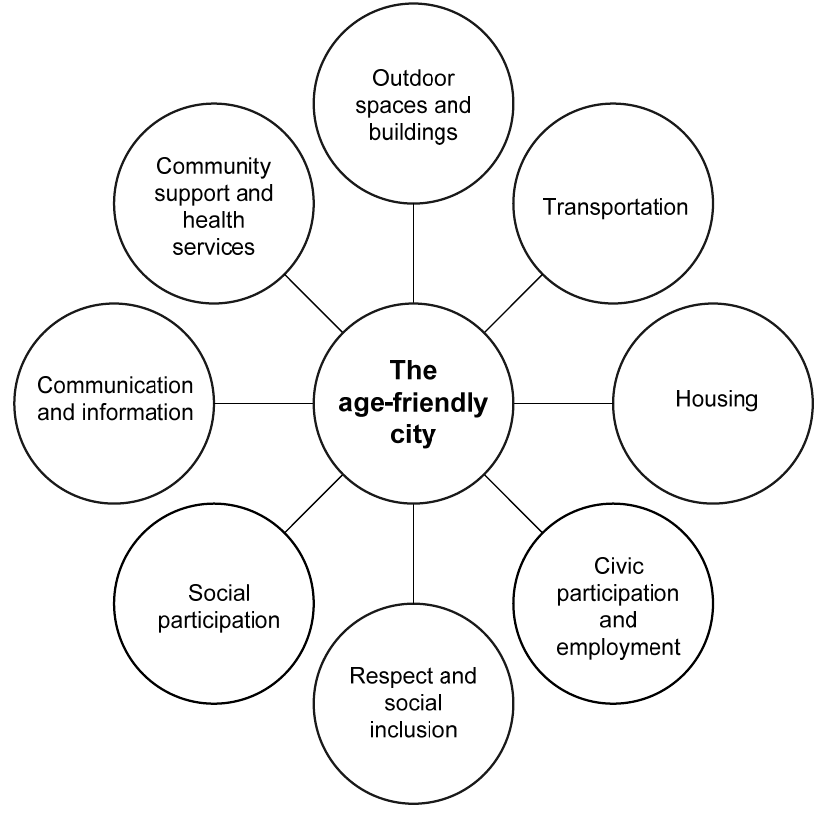
Figure 3. The eight domains of an age-friendly city [36].